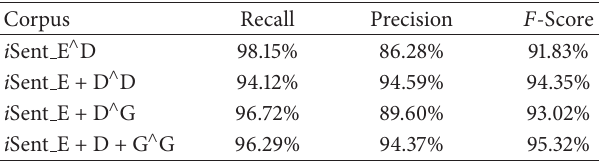
Table 14: Classification results on mixture of Europarl